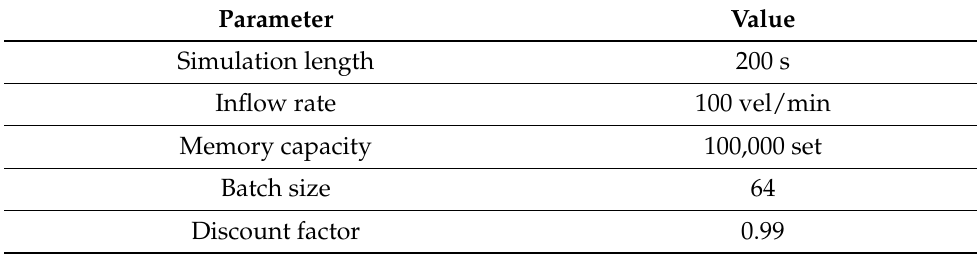
Table 3. Parameters used in training